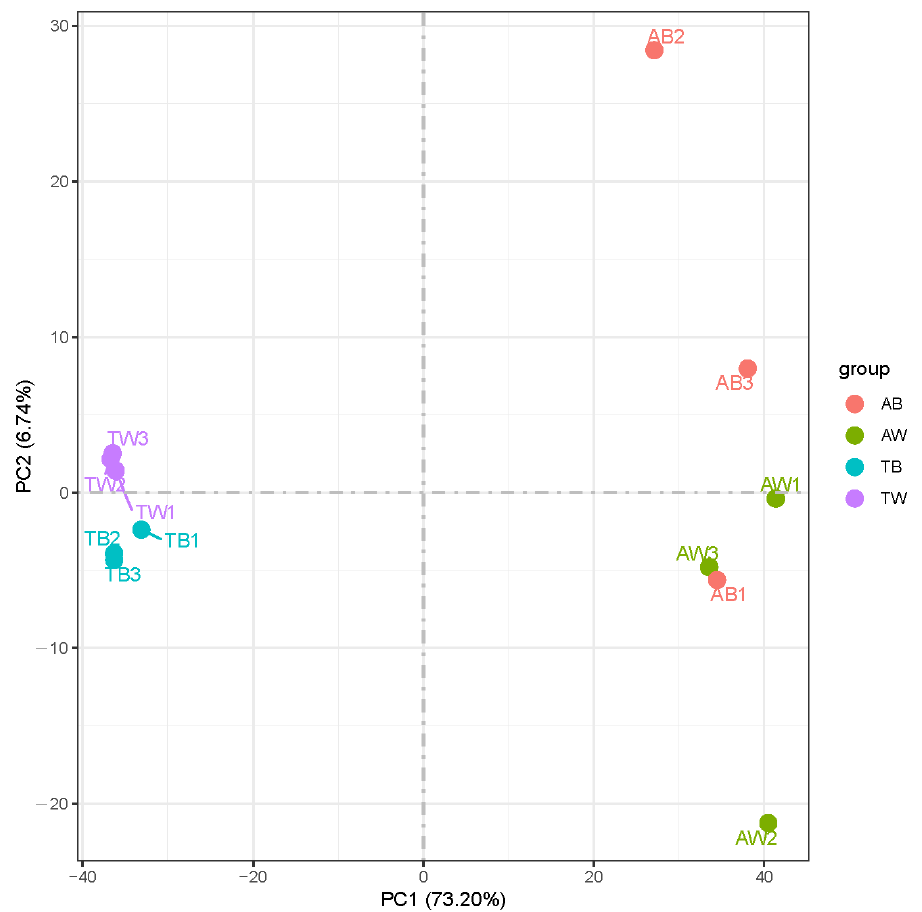
Figure 3. Principal component analysis (PCA). The abscissa is the first principal component, and the ordinate is the second principal component.